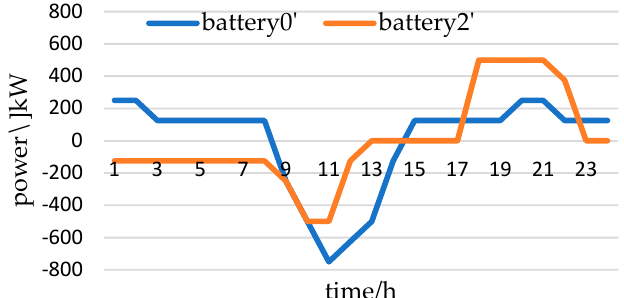
Figure 11. The power output of the ESSs after merging.